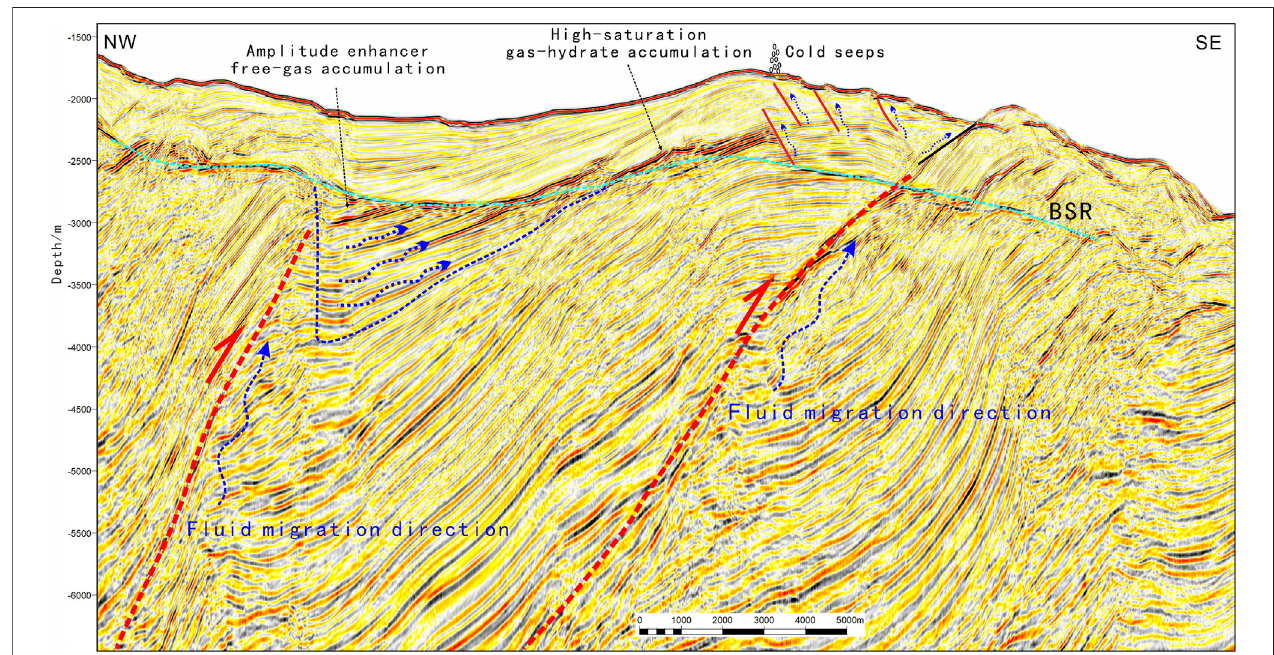
FIGURE 3 | Schematic diagram of the amplitude-enhanced re fl ectors above and below the BSRs and the highly permeable strata for fl uid transport in the Makran Accretionary Prism (the section position shown in Figure 1 ).